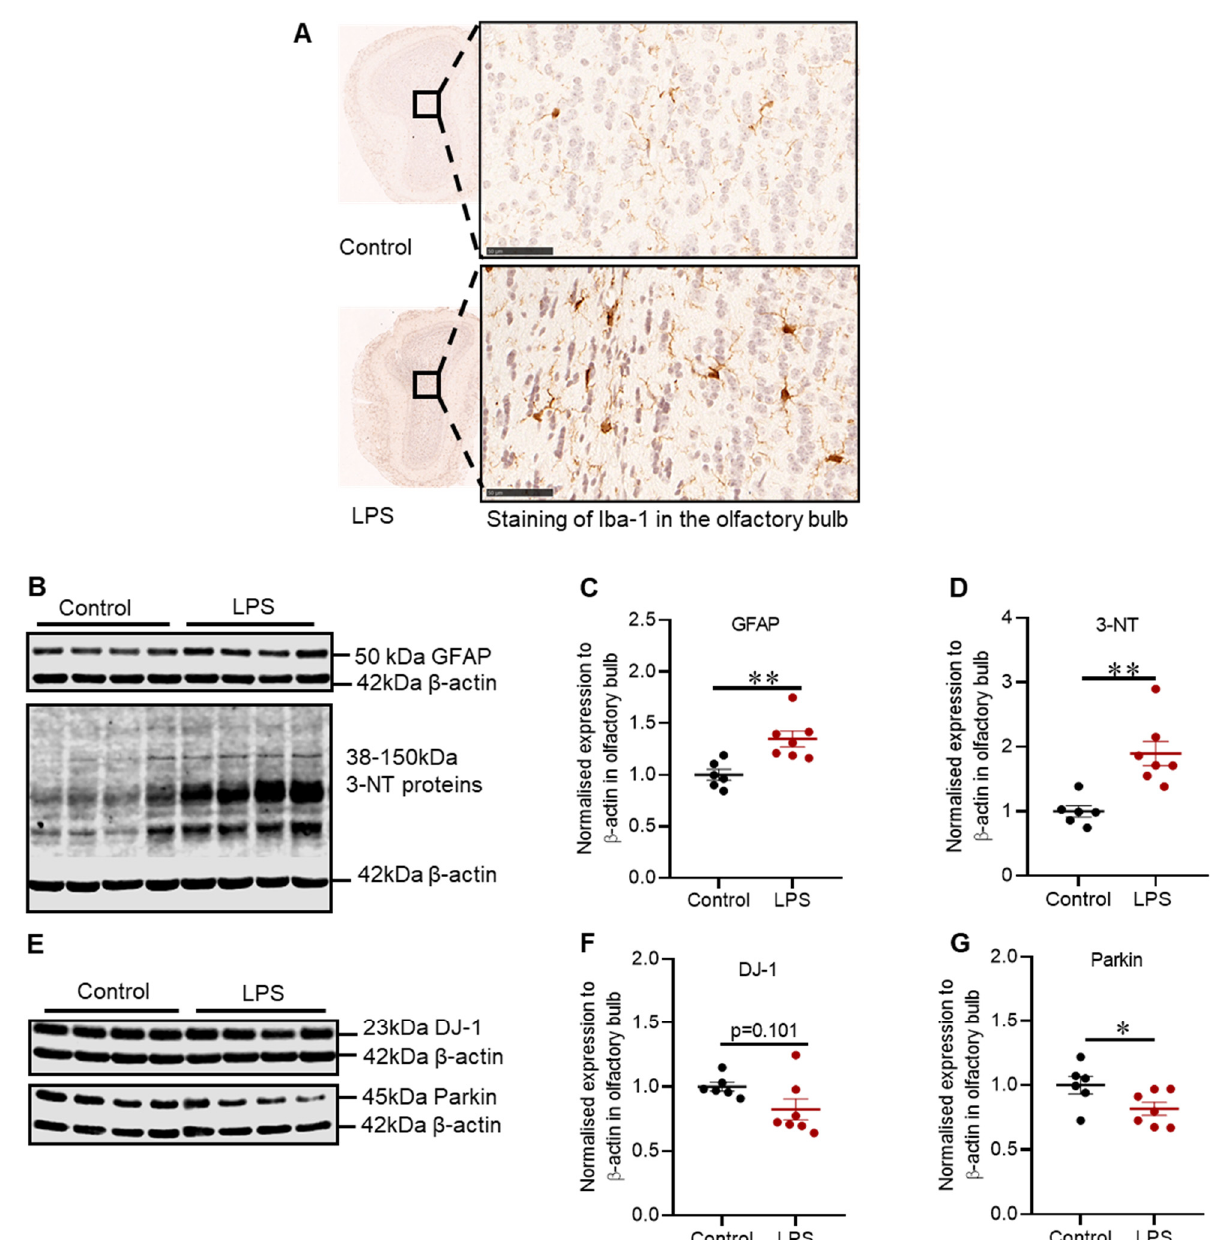
Figure 5. Intrastriatal administration of LPS altered the expression of inflammatory and oxidative stress markers and proteins involved in defence mechanisms against oxidative stress in the olfactory bulb of C57BL/6 mice. ( A ) Representative images for immunohistochemical detection of Iba-1 in the olfactory bulb. ( B ) Representative immunoblots for GFAP and 3-NT proteins in the olfactory bulb. ( C ) Densitometric analysis of GFAP protein. ( D ) Densitometric analysis of 3-NT protein. ( E ) Representative immunoblots for DJ-1 and parkin in the olfactory bulb (involved in defence against oxidative stress). ( F ) Densitometric analysis of DJ-1 protein. ( G ) Densitometric analysis of parkin protein. The results are presented as mean ± SEM (control n = 6; LPS n = 7). Statistical analysis was performed with a Mann–Whitney test, p < 0.05 (*), p < 0.01(**). Immunohistochemical detection of Iba-1 (scale bar: 50 µm; microscopic magnification: X400) (control n = 5; LPS n = 5).